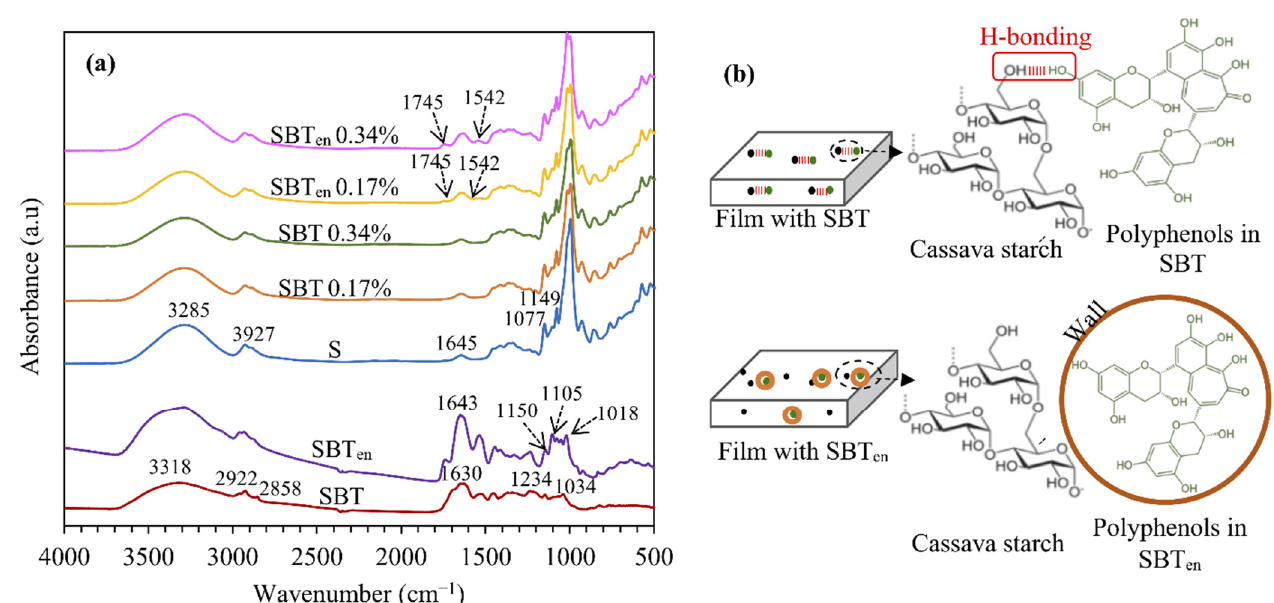
Figure 1. ( a ) FTIR spectra of spray-dried SBT and SBT en , starch-based films without (S), and with SBT or SBT en ; ( b ) Schematic illustration of interaction between starch and SBT polyphenols in active films with SBT or SBT en .